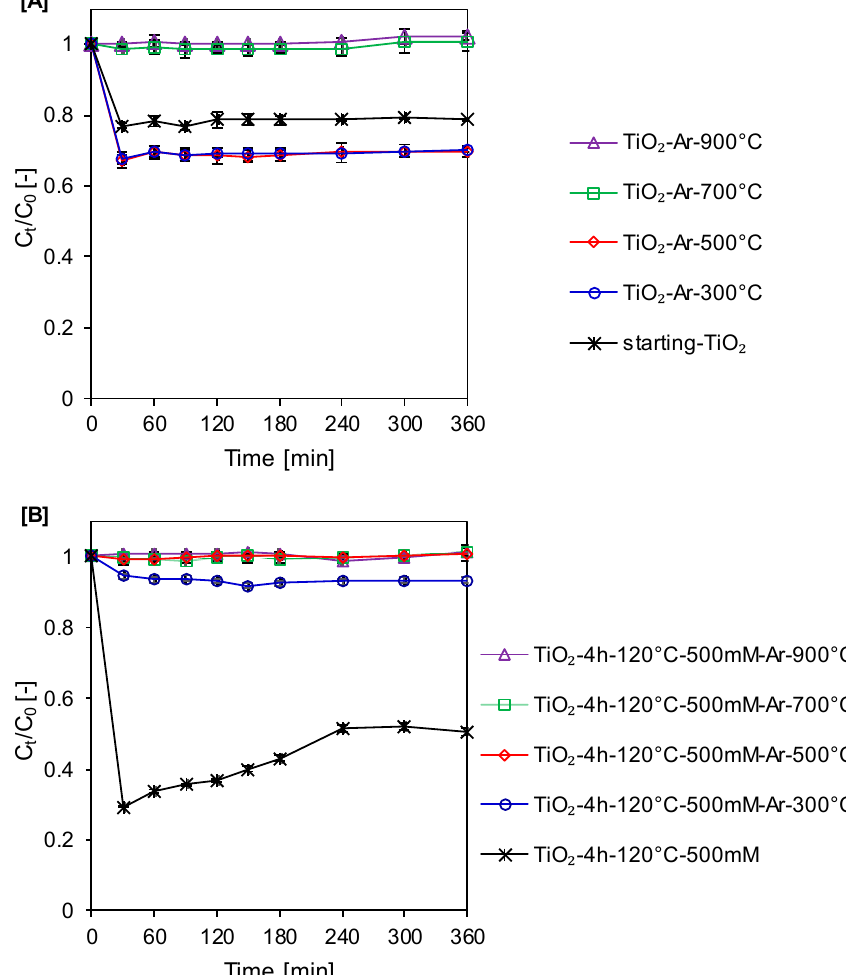
Figure 6. Adsorption degree of Orange II dye on the surface of starting TiO 2 and calcined reference samples ( A ), and APTES-modified TiO 2 before and after calcination process ( B ).